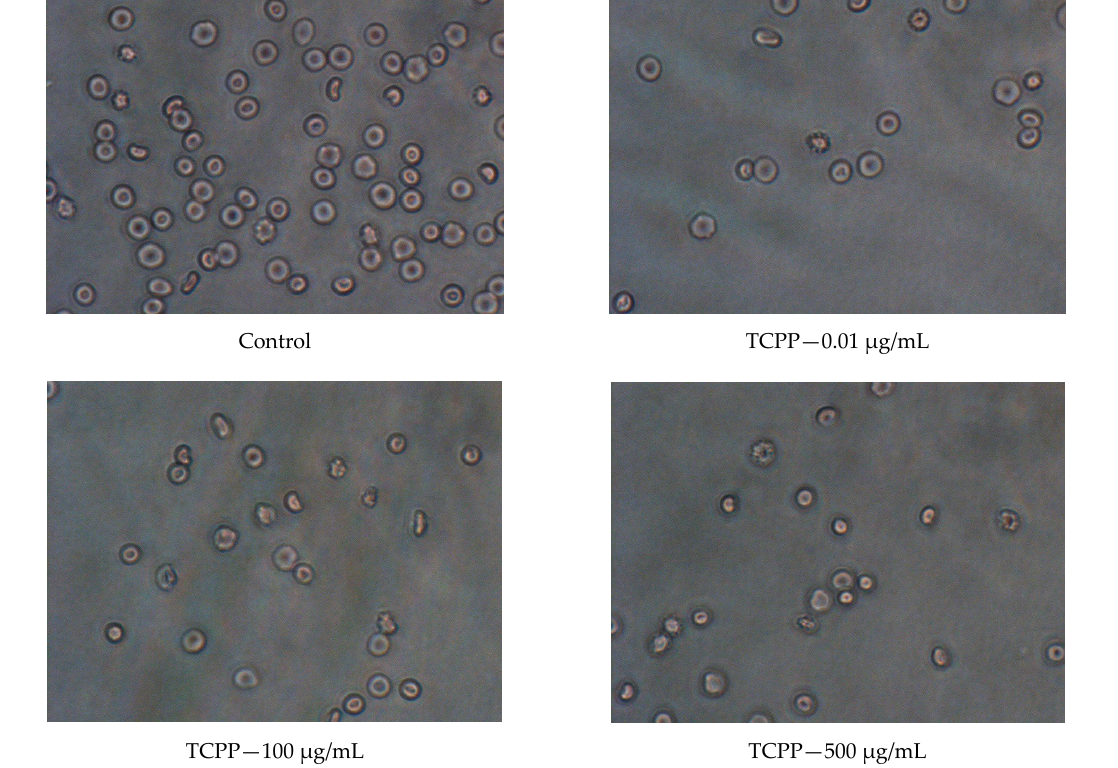
Figure 4. ( A ) Micrographs of control erythrocytes and erythrocytes incubated with TCEP at concentrations from 0.01 to 500 μ g/mL for 24 h. ( B ) Micrographs of control erythrocytes and erythrocytes incubated with TCPP at concentrations ranging from 0.01 to 1000 μ g/mL for 24 h. TCEP and TCPP caused statistically significant changes in the FSC parameter (Figure 5). TCEP at 100 μ g/mL and TCPP at 500 μ g/mL decreased the FSC parameter in the incu- bated cells.